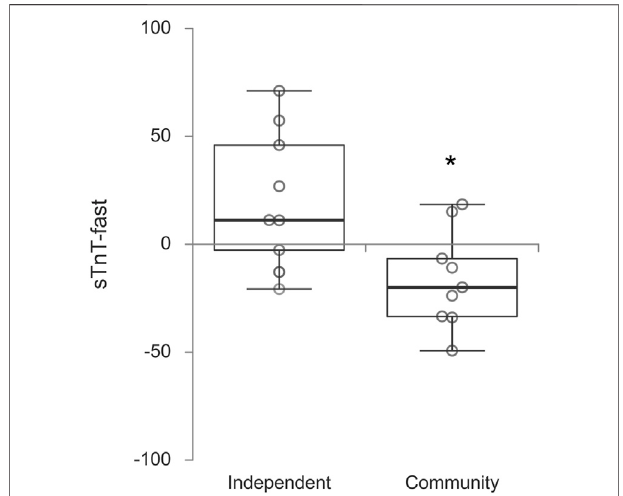
FIGURE 4 | Box plots of percent changes after the exercise program SSSHinskeletalmuscletroponinTfastperdwelling.Signi fi canceindicatedby * ( p =